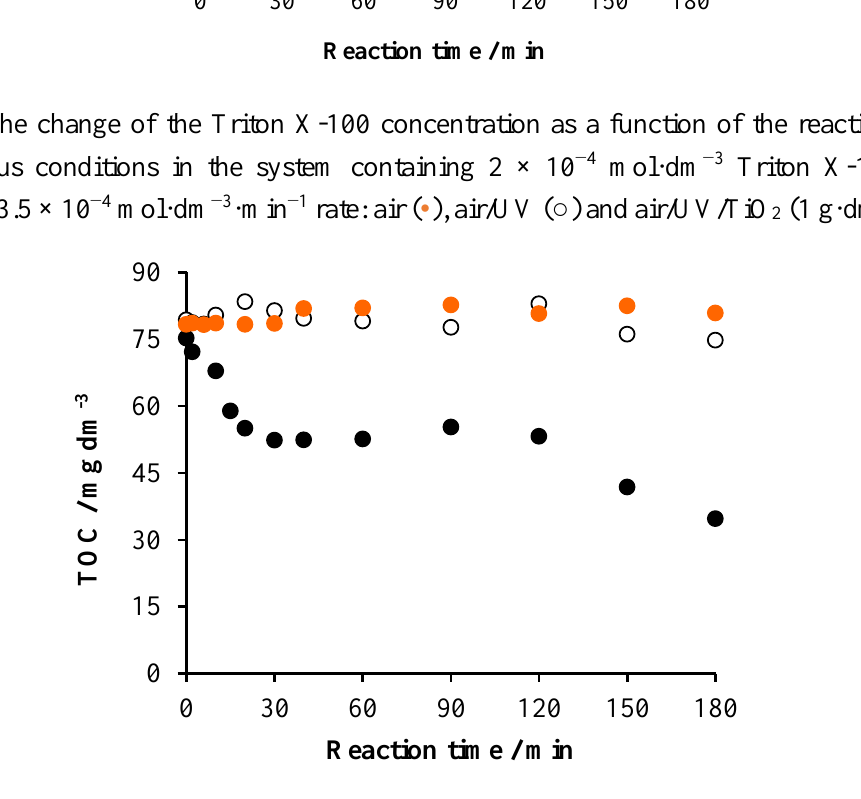
Figure 9. The change of the TOC as a function of the reaction time under various conditions in the system containing 2 × 10 −4 mol·dm −3 Triton X-100 and ozonated at 3.5 × 10 −4 mol·dm −3 ·min −1 rate: air (•), air/UV (○) and air/UV/TiO 2 (1 g dm −3 )